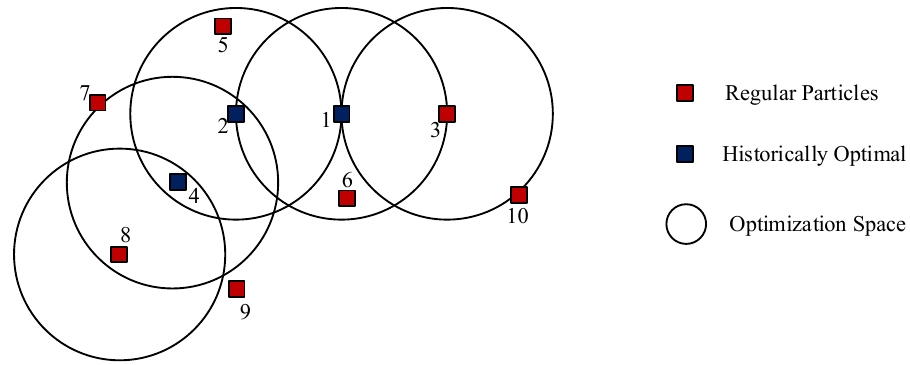
Figure 1. Schematic diagram of the multi-objective particle swarm optimization.